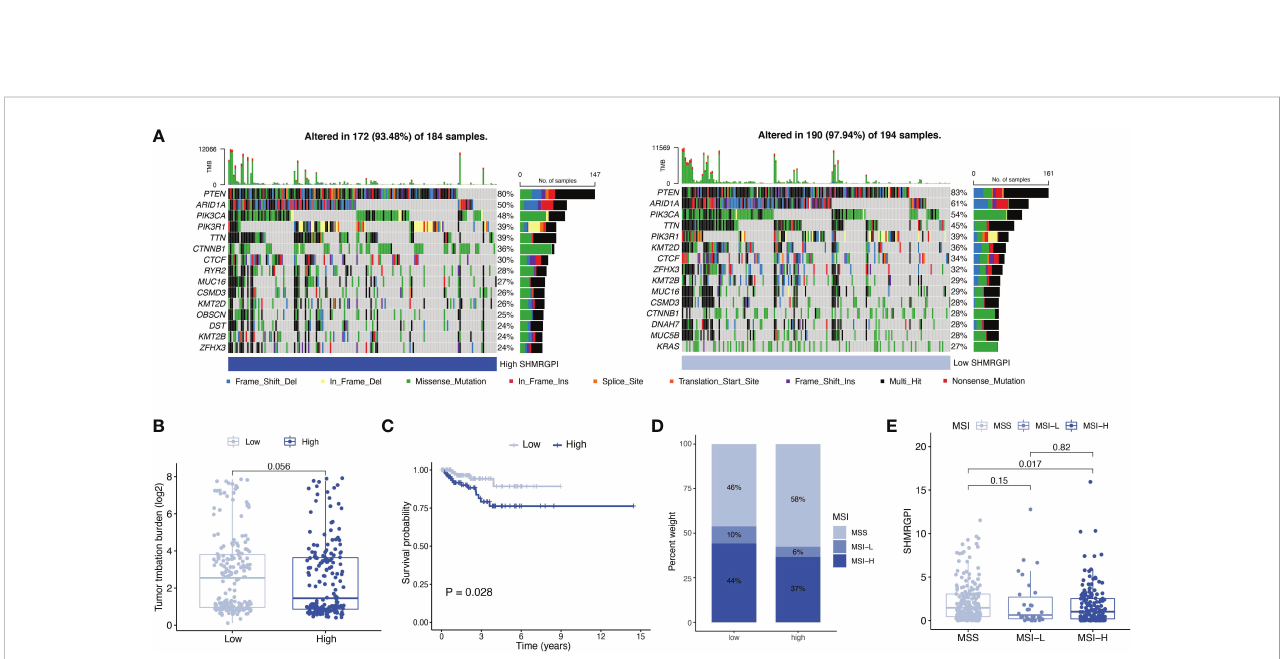
FIGURE 7 Analysis of mutation data. (A) Waterfall plot for somatic mutations in different SHMRGPI groups. (B) Differential analysis of TMB in different SHMRGPI groups. (C) Kaplan – Meier curves of survival differences between the SHMRGPI groups in patients with low TMB. (D) Distribution of MSI status in the different SHMRGPI groups. (E) Differential analysis of the SHMRGPI in patients with different MSI status. TMB, tumor mutation burden; MSI, microsatellite instability.